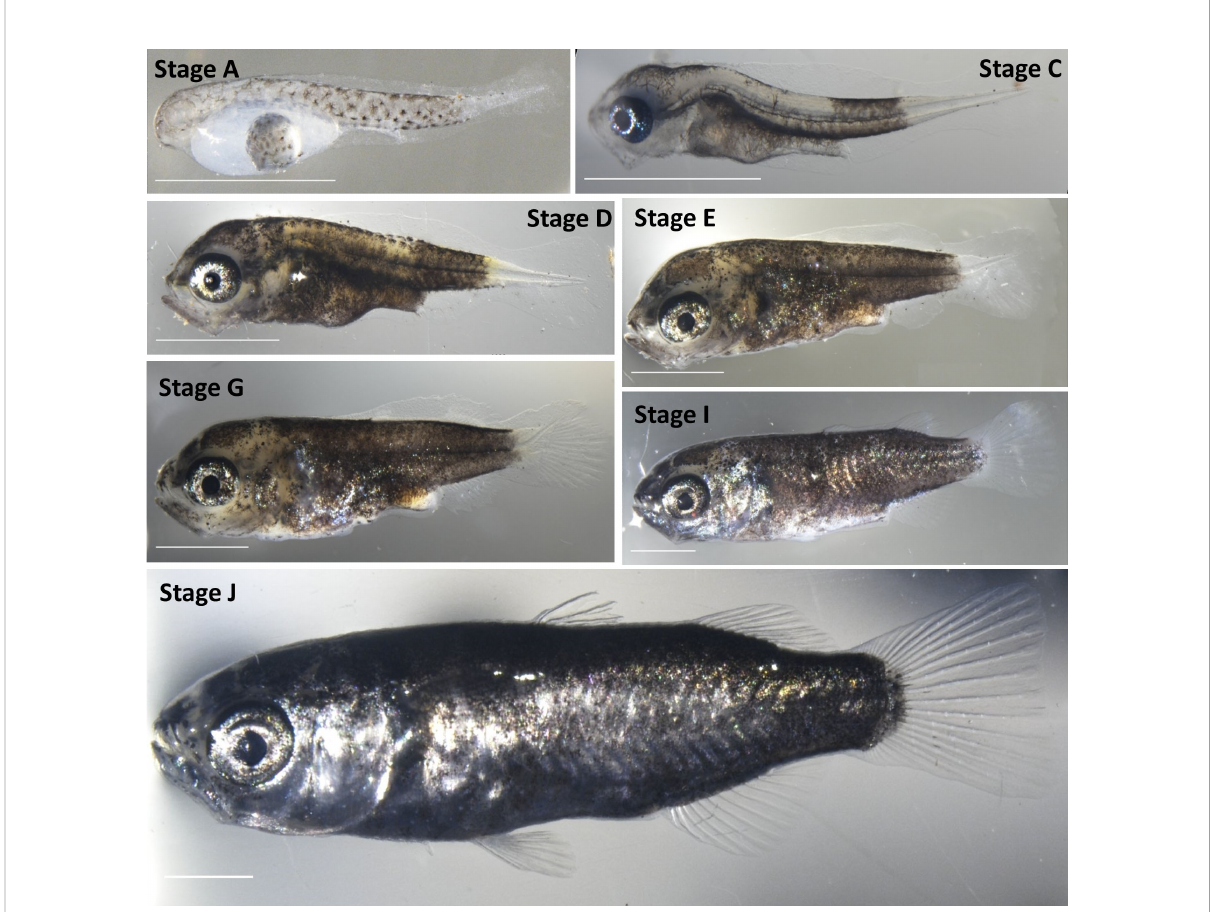
FIGURE 2 Development of pigmentation. Note that stages A to C are largely transparent. Dark pigmentations covers the body except for the caudal region from stage D to G. Silver iridophores fi rst appear at stage E and gradually cover the body until the attainment of a full silver body at stage J. Scale bar-1